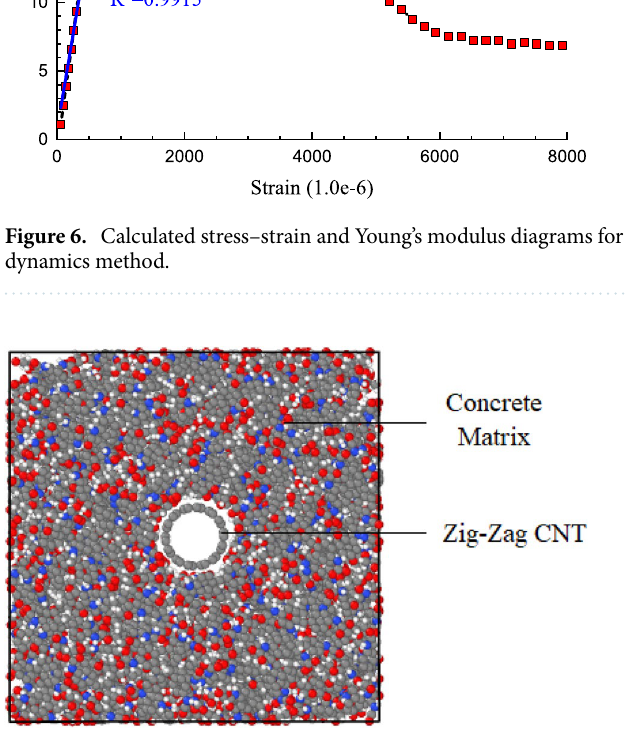
Figure 7. A view of the atomic structure of a concrete matrix with simulated carbon nanotubes in the present study.